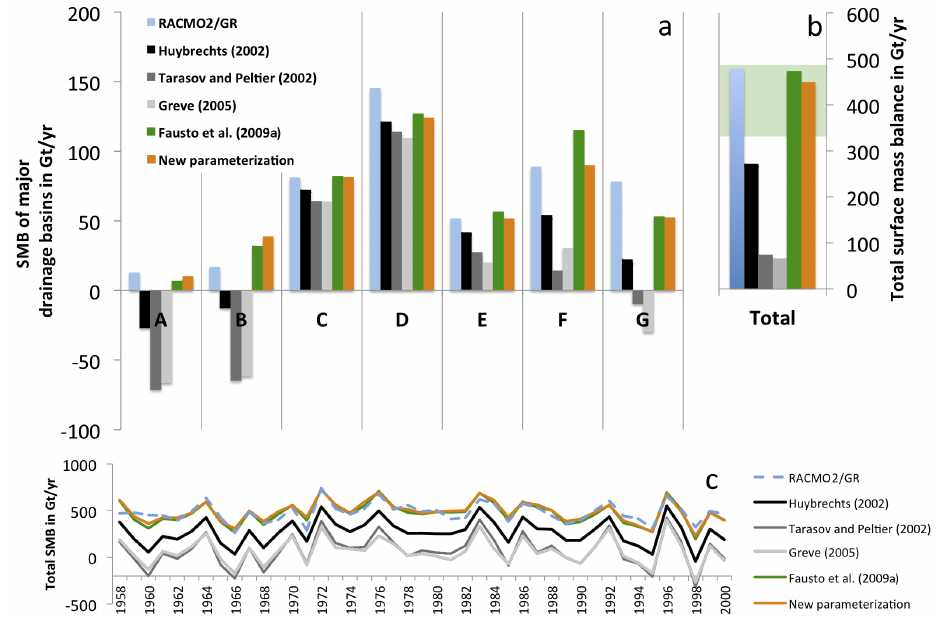
Fig. 4. Comparison of modeled values of regional and total SMB obtained from RACMO2/GR (adopted from Ettema et al., 2009; blue), SMB parameterizations of Huybrechts (2002), Tarasov and Peltier (2002), Greve (2005) (black, dark grey and light grey, respectively) and Fausto et al. (2009a) (green), and the new SMB parameterization with spatially and seasonally variable SD (orange). Fig. 1a and b depict the SMB values averaged over the reference period 1958–2001. Areas A–G are given in Fig. 1. Light green shading in (b) shows the range of independent estimates of total SMB from Vernon et al. (2013) averaged over the period from 1960 to